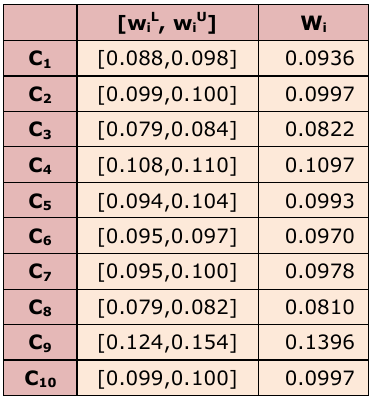
Table 6. The interval and crisp weight of criteria